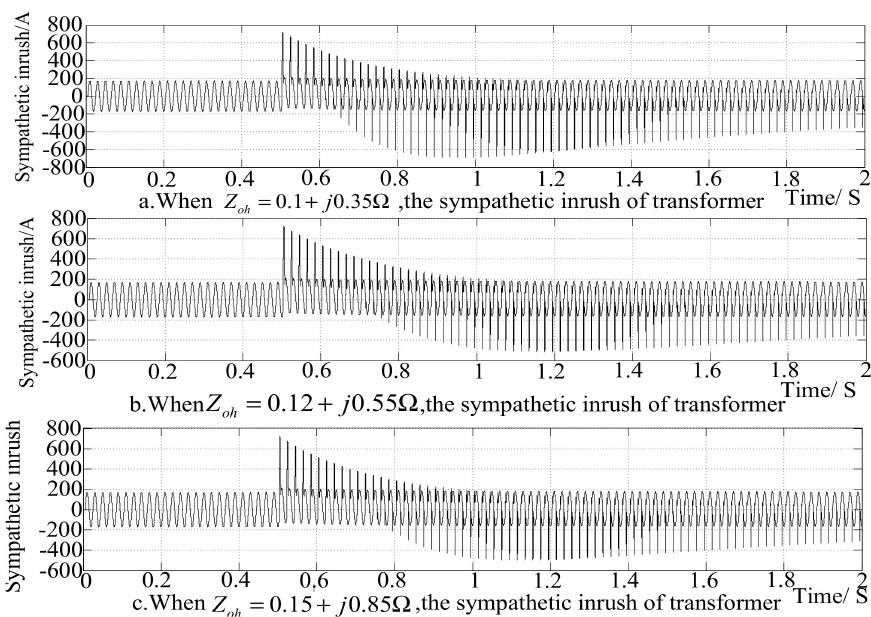
Figure 12. Sympathetic inrush under di ff erent line impedance conditions.